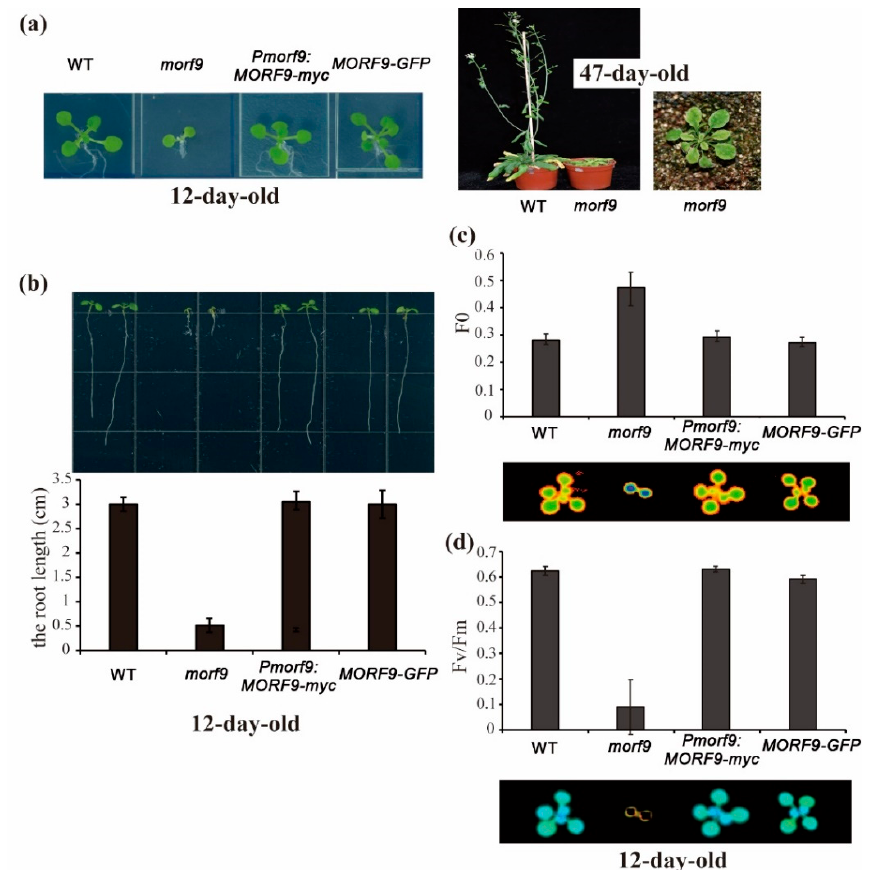
Figure 2. Phenotypes of morf9 mutant and transgenic plants. ( a ) Plants at 12 days after germination in MS medium and at 35 days after transfer to soil; ( b ) Root morphogenesis of the morf9 mutant and transgenic plants. The lower panel shows the average root length of 10 to 20 plants with standard errors; ( c and d ) Imaging and quantification of the leaf initiation fluorescence yield (F0) and efficiency of photosystem II (Fv/Fm) in plants with indicated genetic background at day 12 after germination, respectively. Data represent the mean of at least five plants with SE.